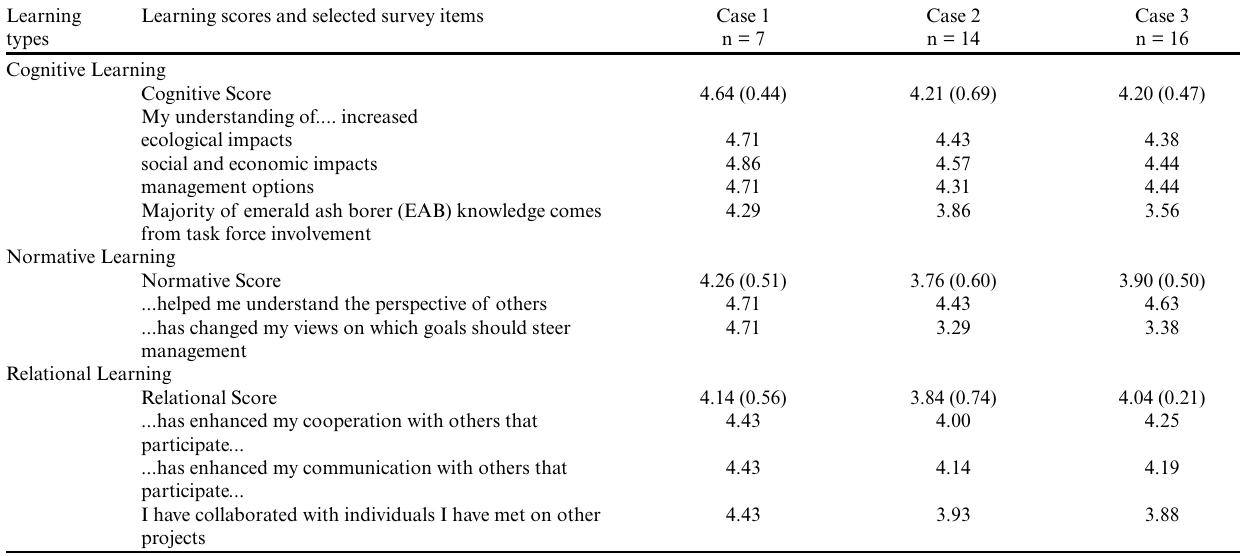
Table 3 . Learning scores averaged by case (and standard deviation) and responses to selected individual survey items averaged by case to illustrate learning typologies (full survey instrument in Appendix I). Score is based on a five-point scale (1-strongly disagree, 2- disagree, 3-neutral, 4-agree and 5-strongly agree). Sample sizes are lower for learning data due to incomplete survey